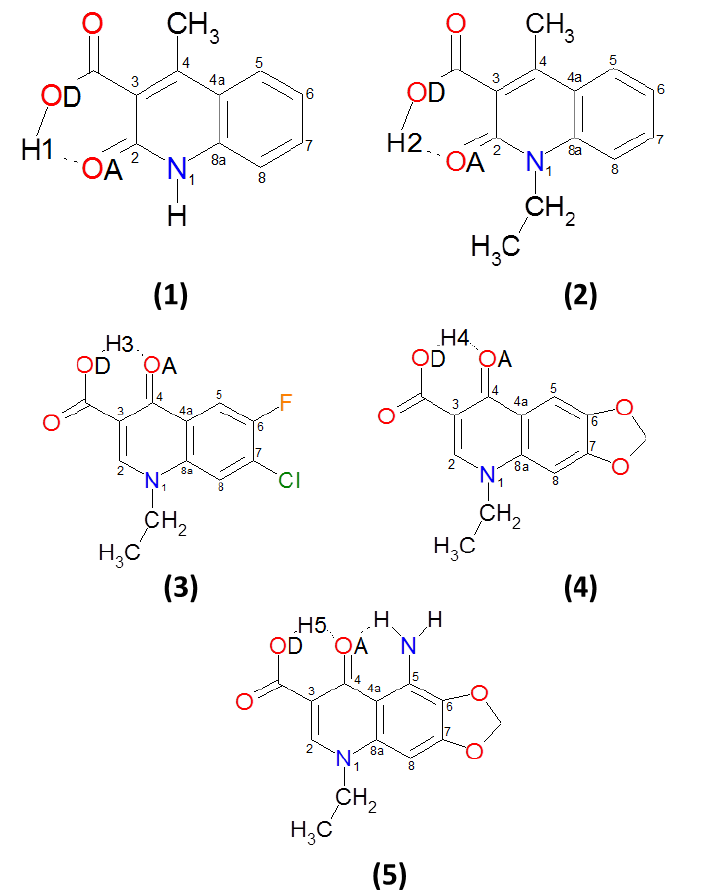
Figure 1. Molecular structures of the studied quinolone carboxylic acid derivatives. The dotted line indicates the presence of an intramolecular hydrogen bond. The OD indicates the proton-donor oxygen atom, while OA indicates the proton-acceptor oxygen atom. Hn indicates the bridged proton in the hydrogen